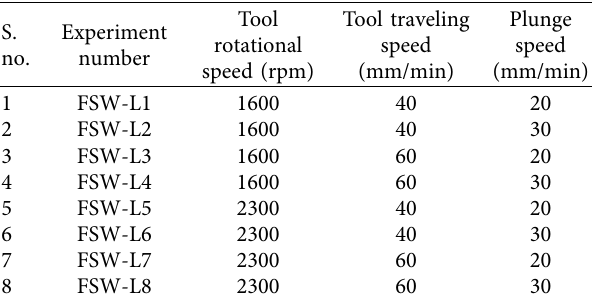
Table 5: Factors set based on L8 orthogonal